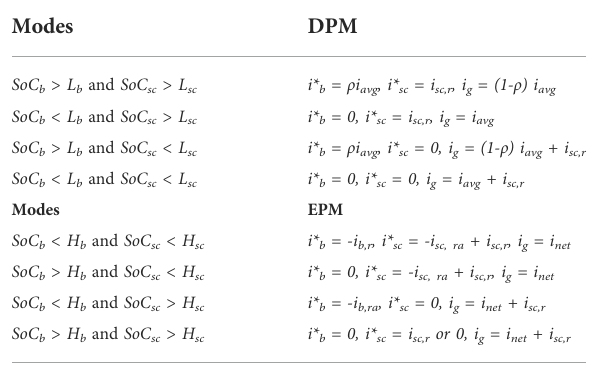
TABLE 1 A DPM. B EPM.